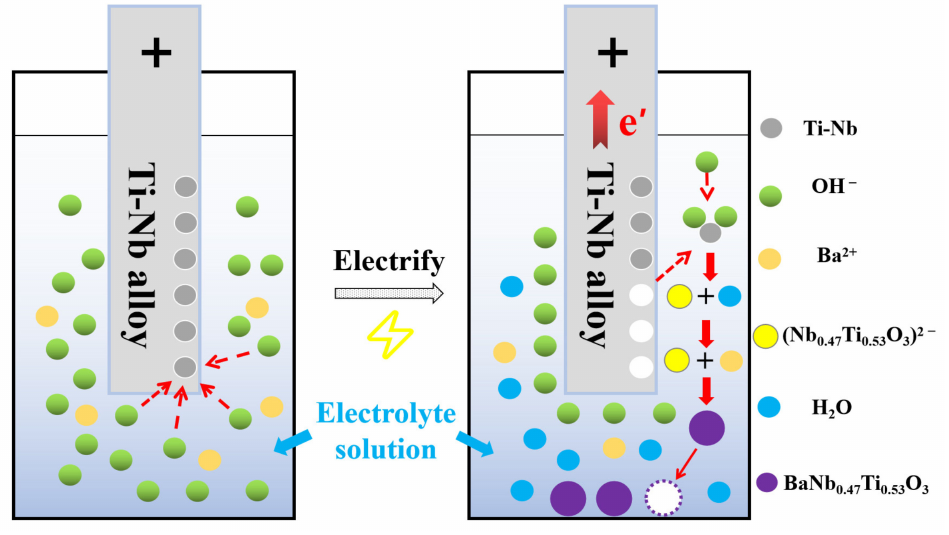
Figure 6. Anodic chemical reaction